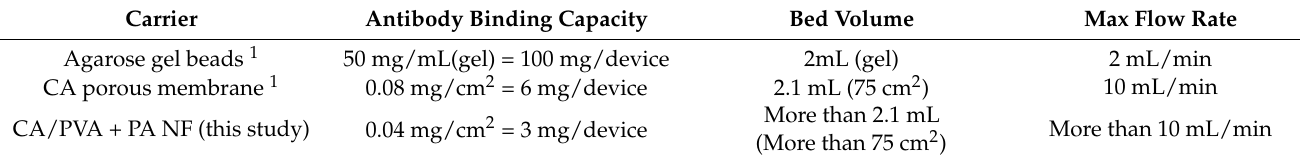
Table 1. Comparison of fabricated NF with commercialized PA-immobilized substrate. Carrier Antibody Binding Capacity Bed Volume Max Flow Rate Agarose gel beads 1 50 mg/mL(gel) = 100 mg/device 2mL (gel) 2 mL/min CA porous membrane